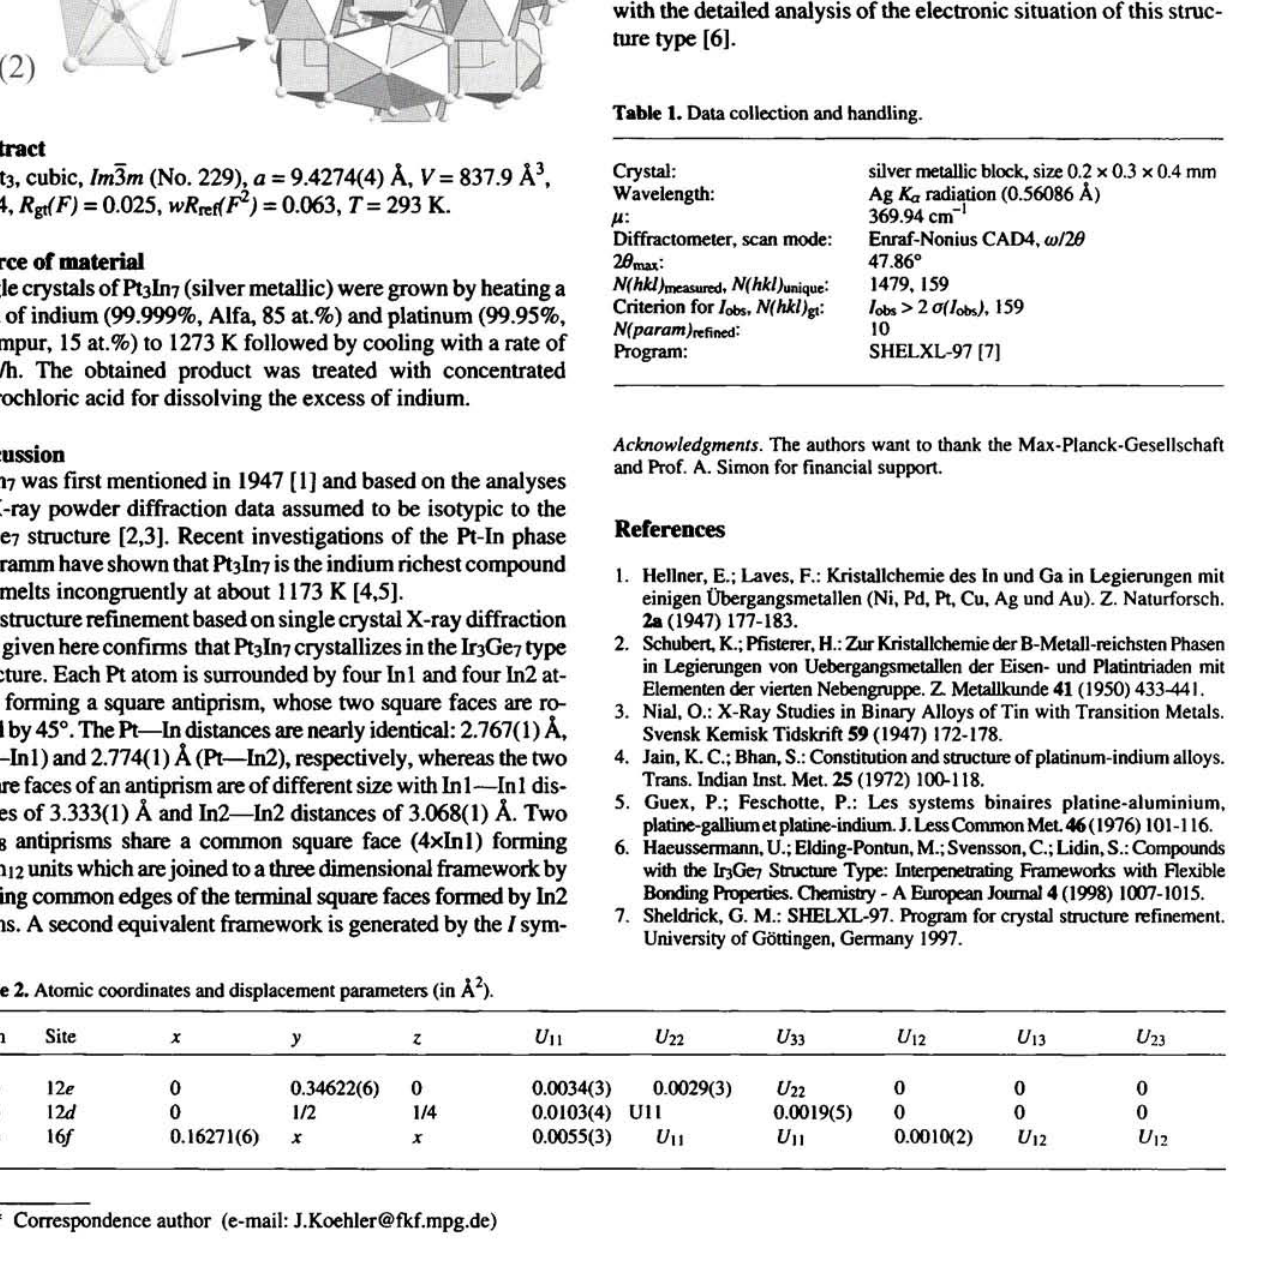
Table 1. Data collection and handling.